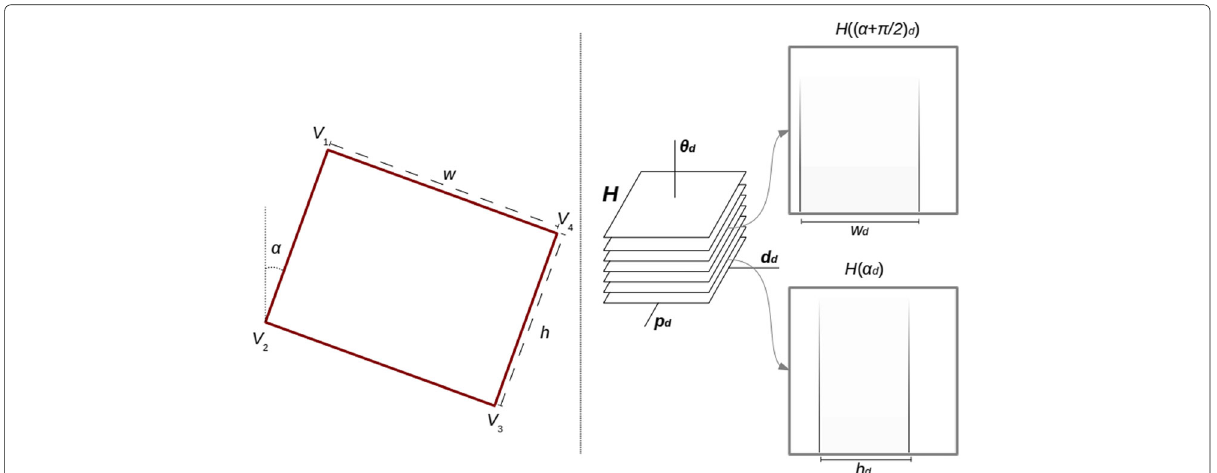
Fig. 9 Rectangle representation in the 3D Hough